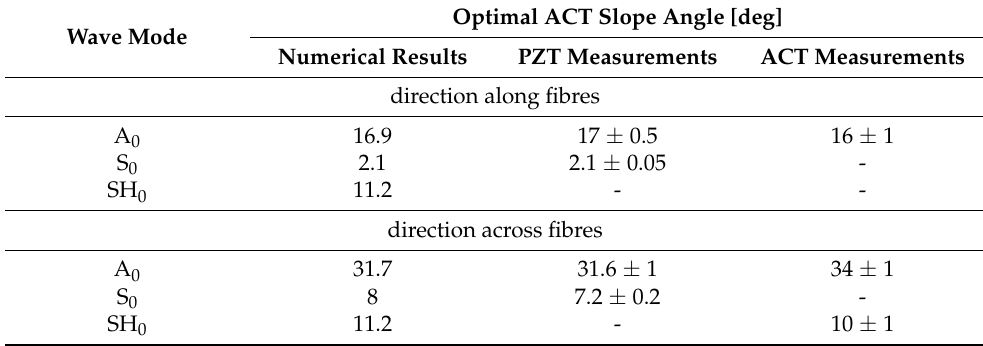
Table 3. Optimal ACT slope angles for different